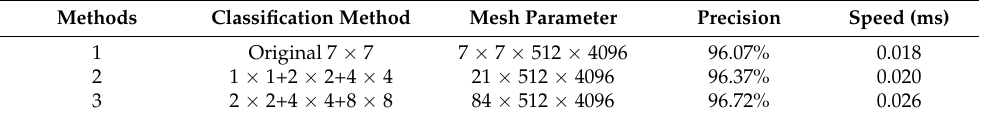
Table 1. ROI pooling layer division scheme.